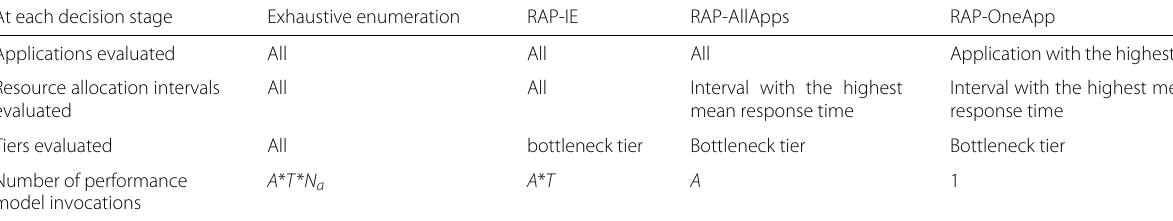
Table 2 Computational complexity of RAP